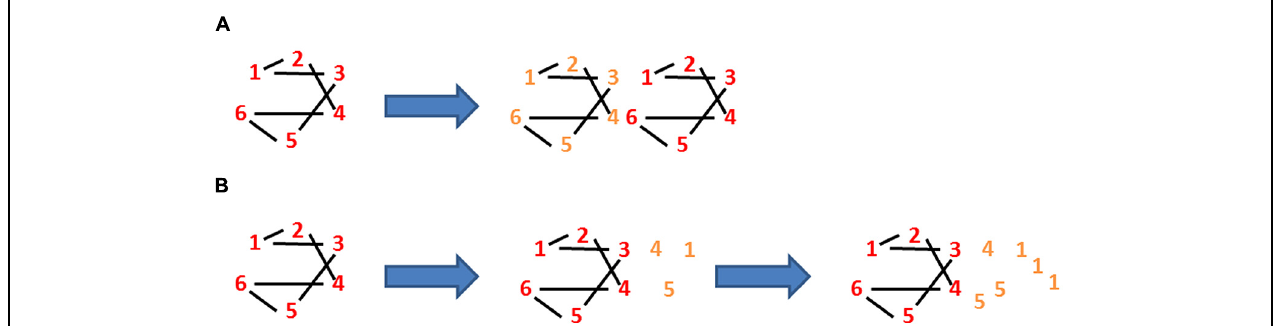
FIGURE 2 | Loss of identity through growth. There are six elements in the autocatalytic set linked by two links per element. (A) The links:elements ratio (L:E) is 1 and stays 1 in the above case as the cell grows. However, this ratio per mass goes down with growth as (L:E)/M goes to (L:E)/2M. (B) After